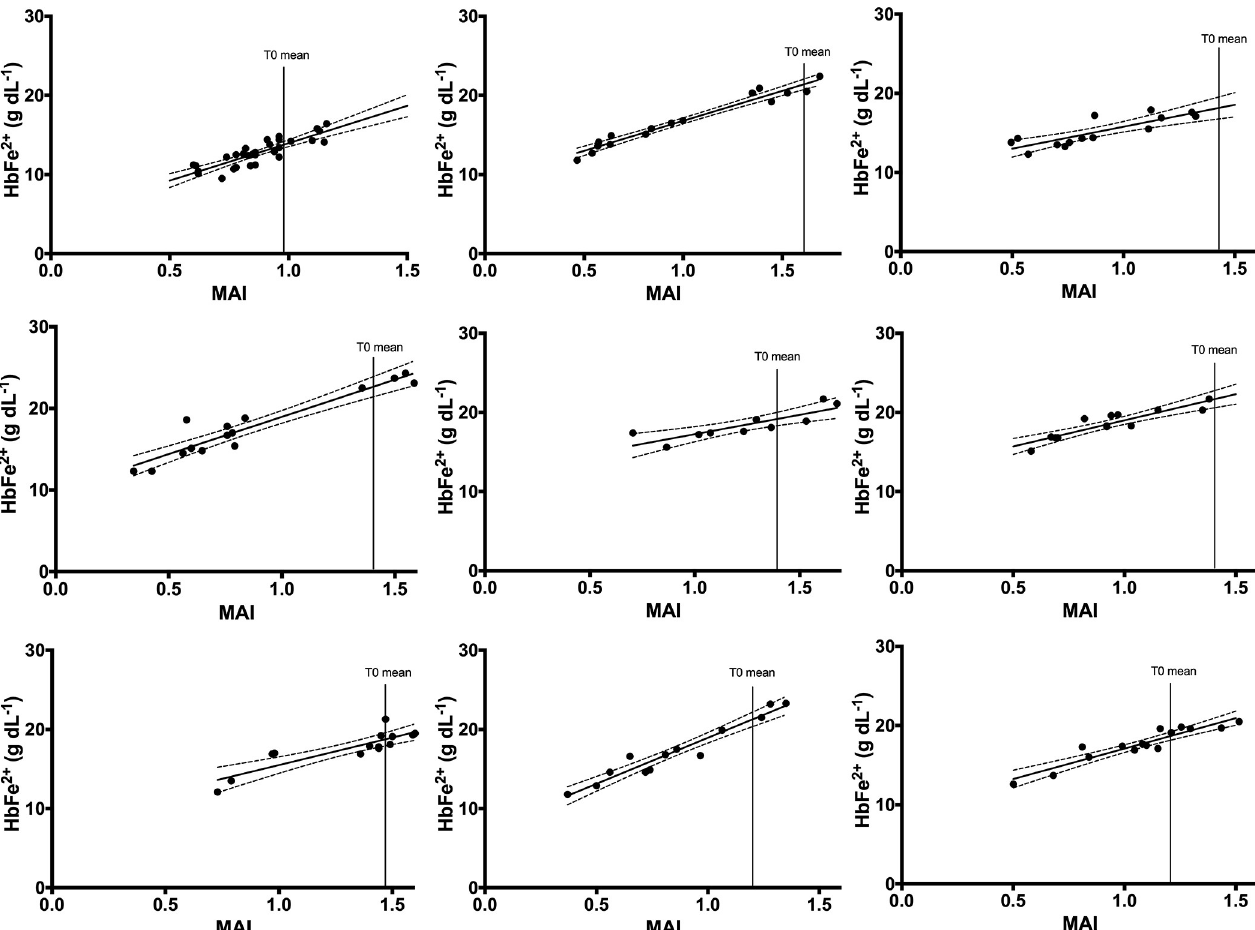
Fig 6. Regression of absorbance data (MAI Eq 1 = 575 nm– 630 nm) with haemoglobin (HbFe 2+ ) at T1 (60 min) and T2 (180 min) for all birds dosed with PAPP ( λ ) at T0 with ST 99 (0.66), LT 50 (0.53) and T0 mean with 95% confidence. Table 2 contains corresponding statistical information (a. Chicken; b. Japanese quail; c. Duck; d. Pukeko; e. Black-Backed Gull; f. Takahe¯; g. Eastern Rosella; h. Weka and i. Kiwi).